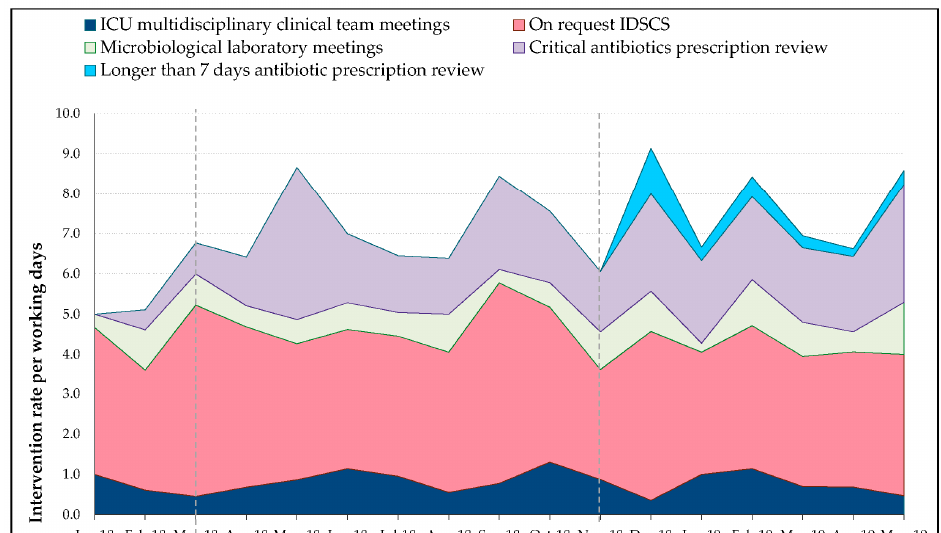
Figure 2. Compliance depending on intervention type. Compliance rate of the 2046 interventions noted in electronic patient record. Abbreviations: ICU, intensive care unit; IDSCS, infectious diseases specialist consulting service; N = number of interventions. Antibiotics 2020 , 9 , x FOR PEER REVIEW